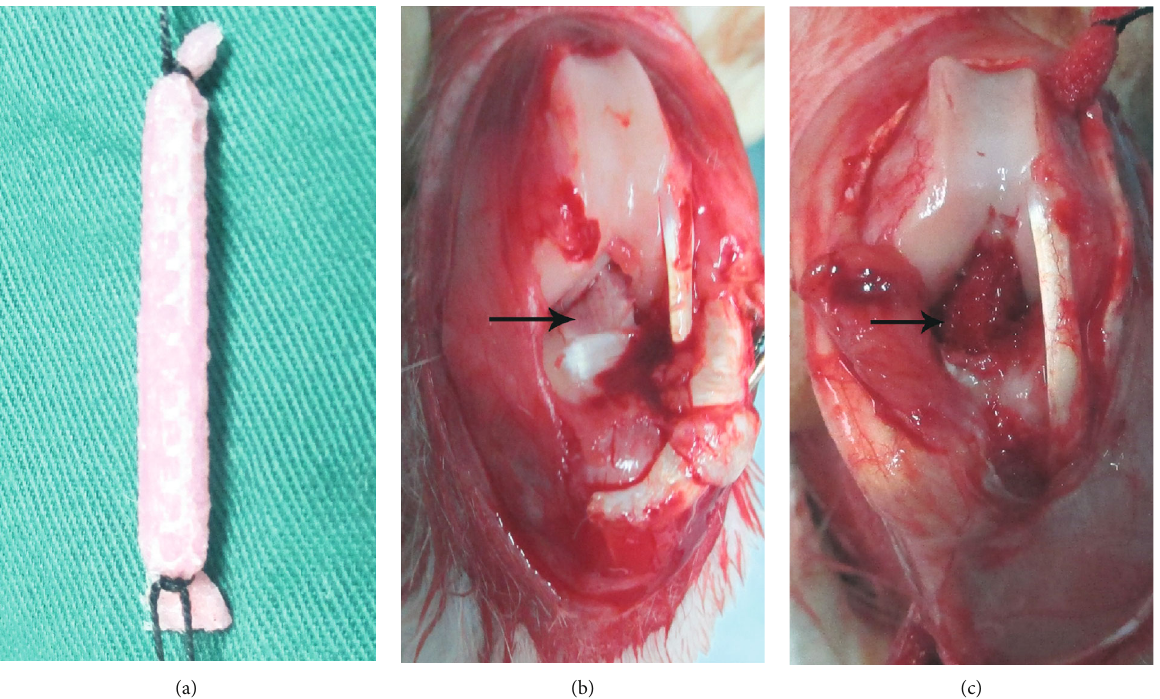
Figure 1: (a) After coculture with BMSCs in the S/C group and immersion only in culture medium in the S group for 72h, the sca ff old was rolled for use as a graft to replace the native ACL in a rabbit model. (b) General observation of the native ACL: the arrow points to the native ACL. (c) General observation of the knee after ACL reconstruction with the sca ff old: the arrow points to the implanted